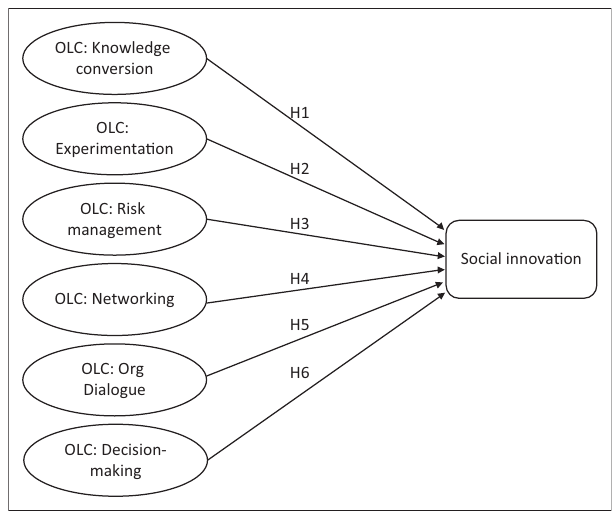
FIGURE 1: Conceptual model of organisational learning capability dimensions and social